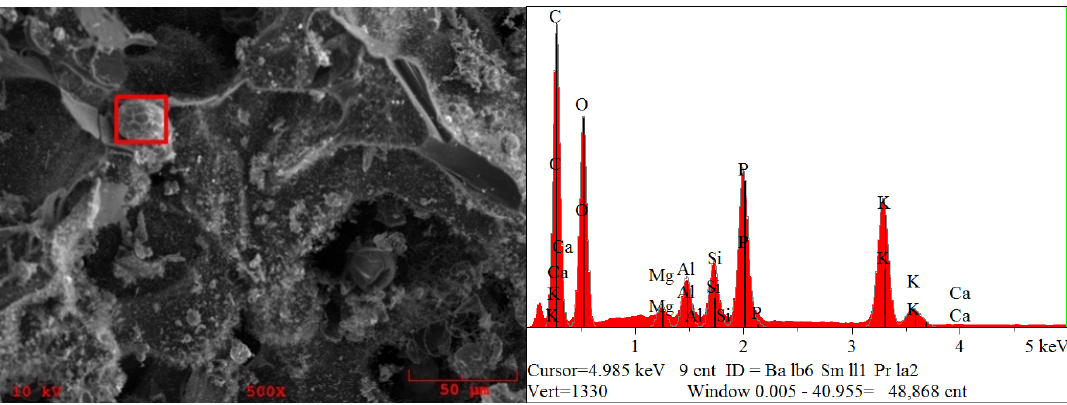
Figure 6. Surface area analysis from corn biochar (Elements from left to right K, C, O, Mg, Al, Si, P, K, Ca).